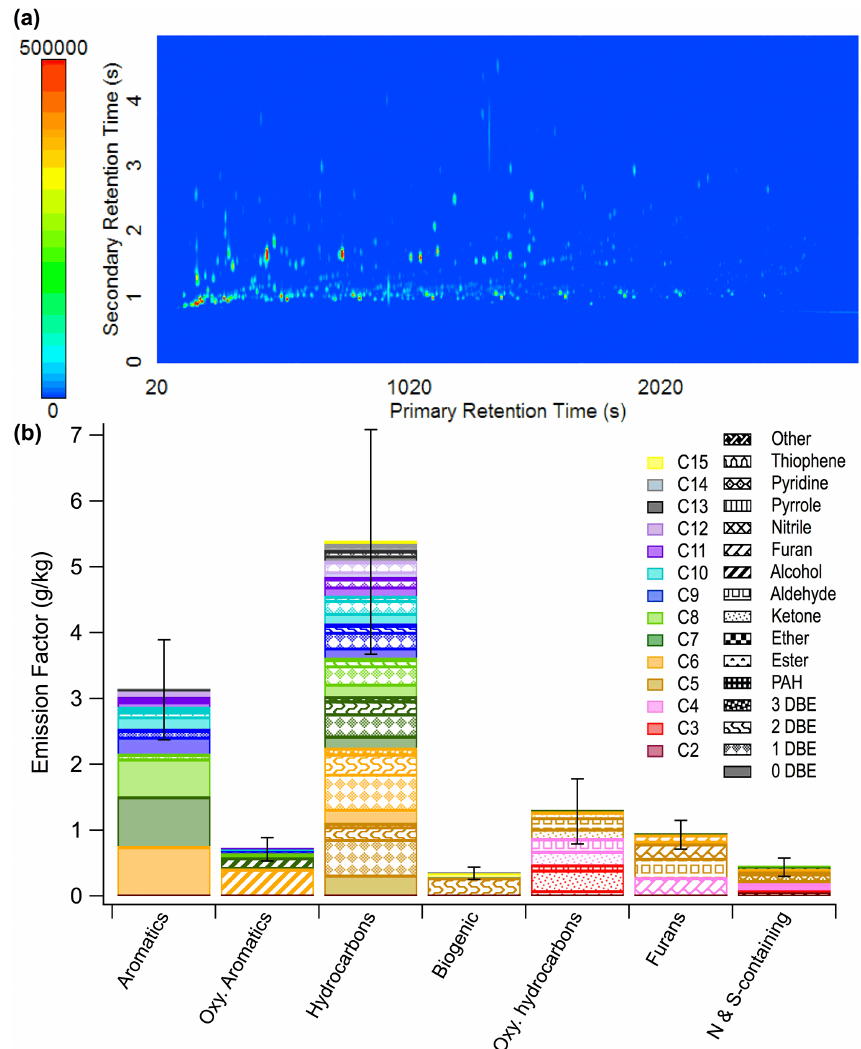
Figure 6. As in Fig. 1, for an Indonesian peat